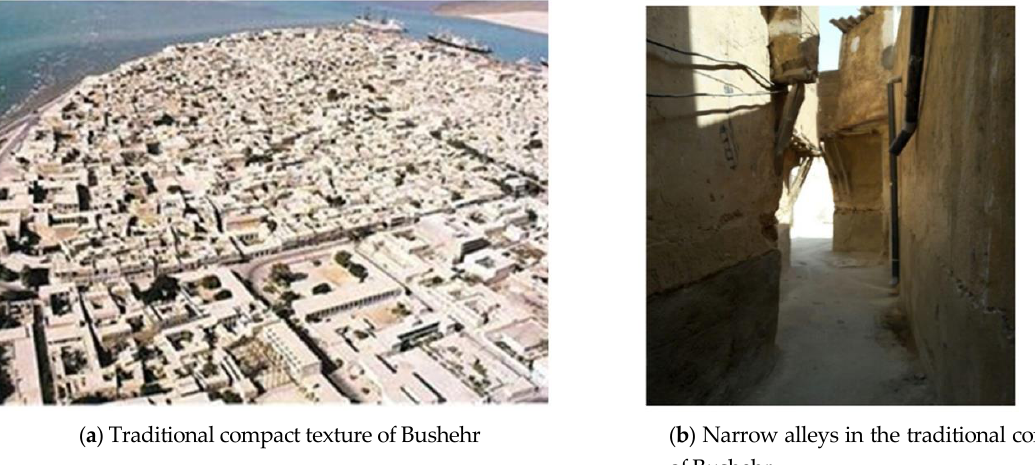
Figure 4. Texture and narrow alleys in the traditional context of Bushehr.